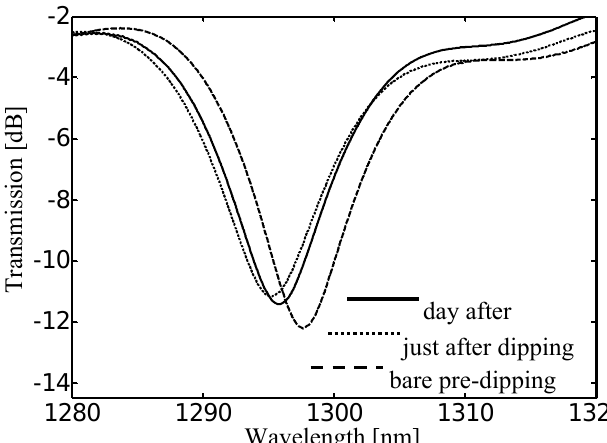
Figure 22. Shift of the attenuation band related to the cladding mode LP deposition of a 160 nm s-PS